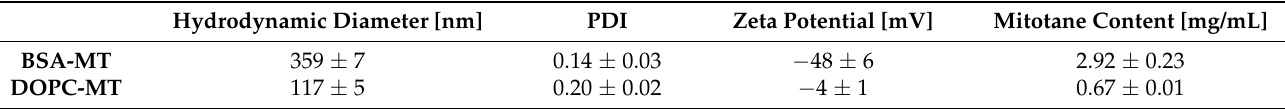
Table 1. Hydrodynamic diameter, polydispersity index (PDI), zeta potential, and mitotane content of albumin-stabilized mitotane (BSA-MT) and liposomal mitotane (DOPC-MT). Data are expressed as mean ± SD, n ≥